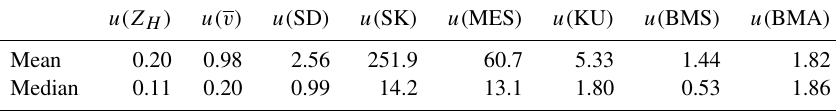
Table 2. Mean and median values of all uncertainty estimates shown in Fig.